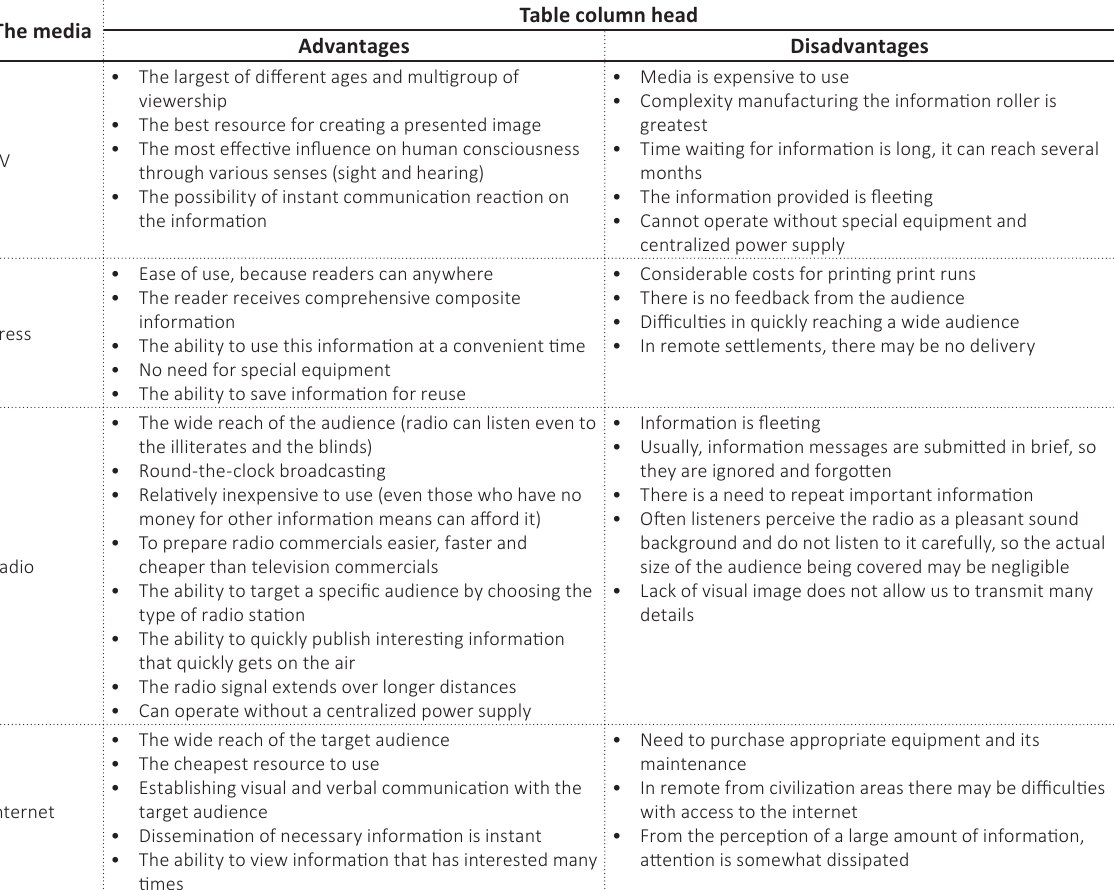
Table 1. Main advantages and disadvantages of using mass media for commercial promotion of university